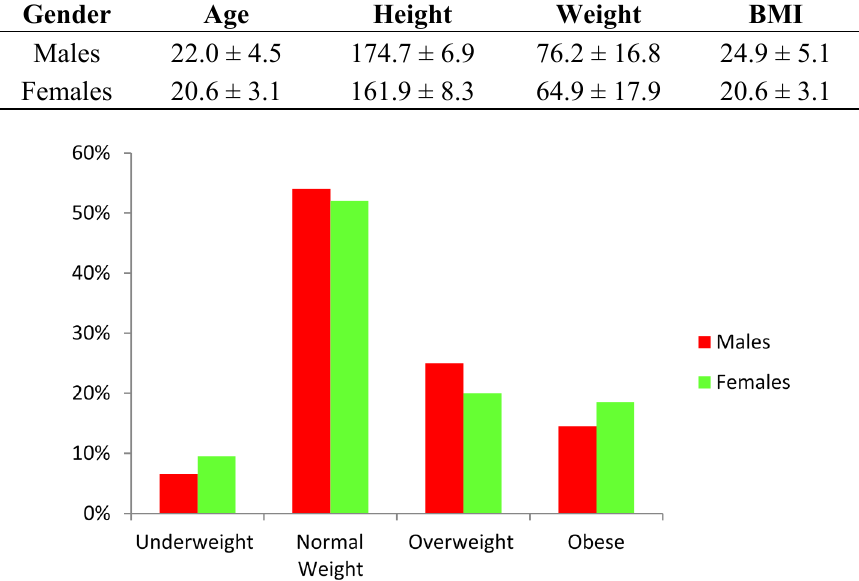
Figure 1. Body mass index (BMI) classification in males and